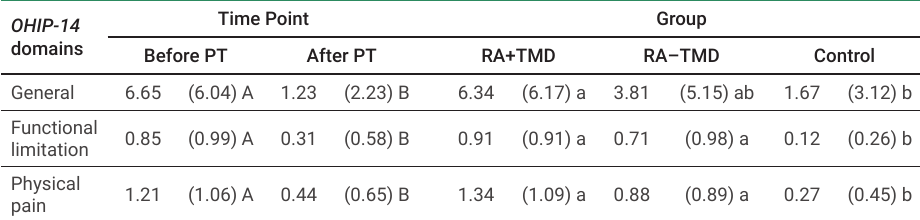
Table 3. Mean (standard deviation) of OHIP-14 domains with significant